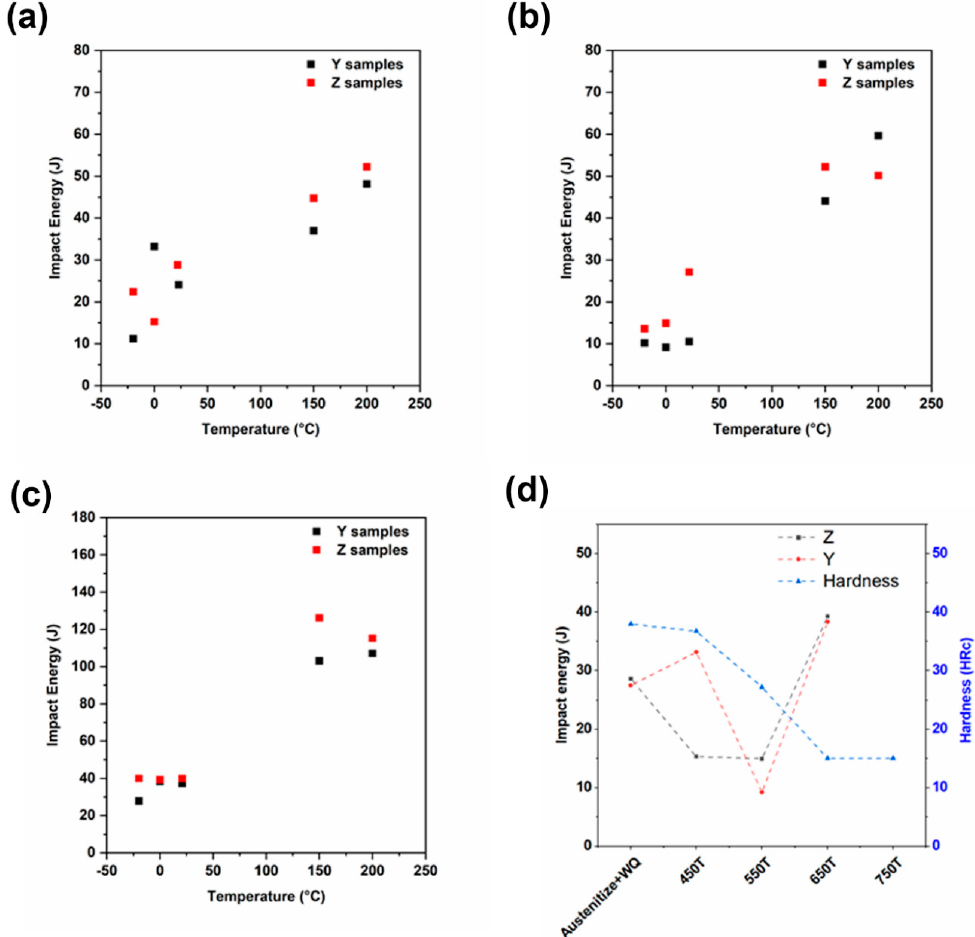
Figure 15. Charpy impact toughness results on samples tempered at ( a ) 450 ° C; ( b ) 550 ° C; ( c ) 650 ° C. ( d ) Plot showing toughness and hardness of different samples at 0°C test temperature.